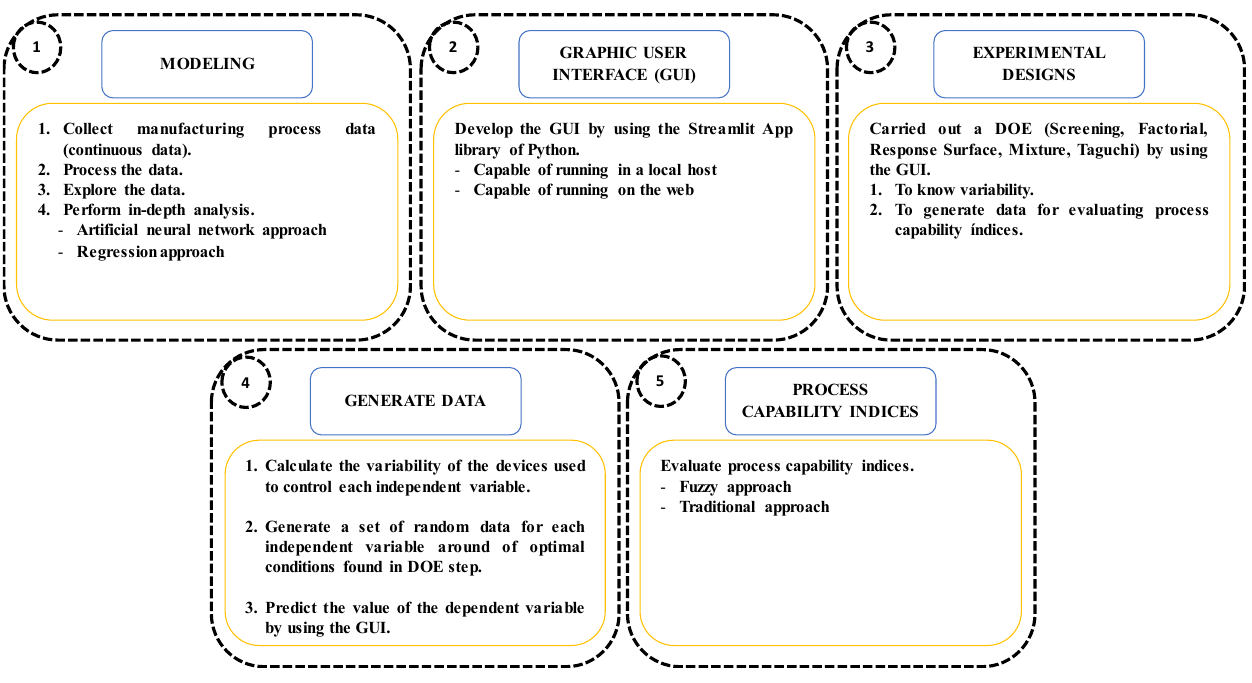
Figure 1. A non-invasive method to evaluate fuzzy process capability indices (Non-I FPCA).